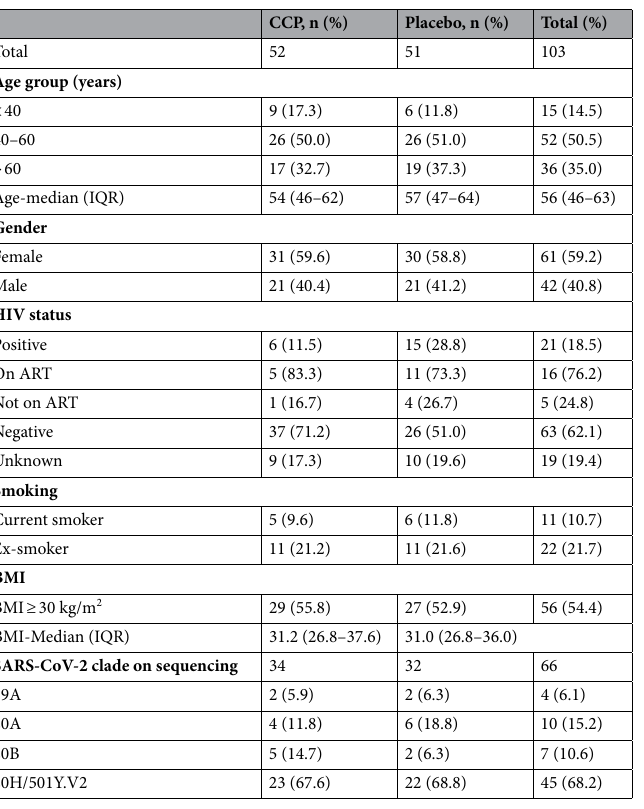
Table 1. Participant characteristics at baseline in 103 participants with severe COVID-19 randomized to treatment with convalescent plasma versus